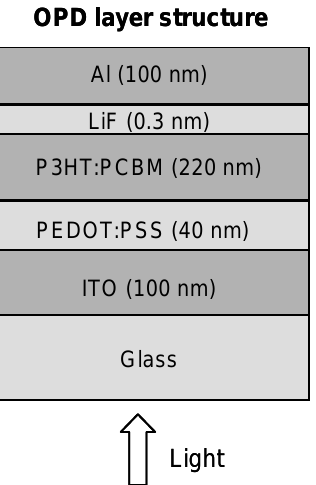
Figure 1. Schematic illustration of the OPD